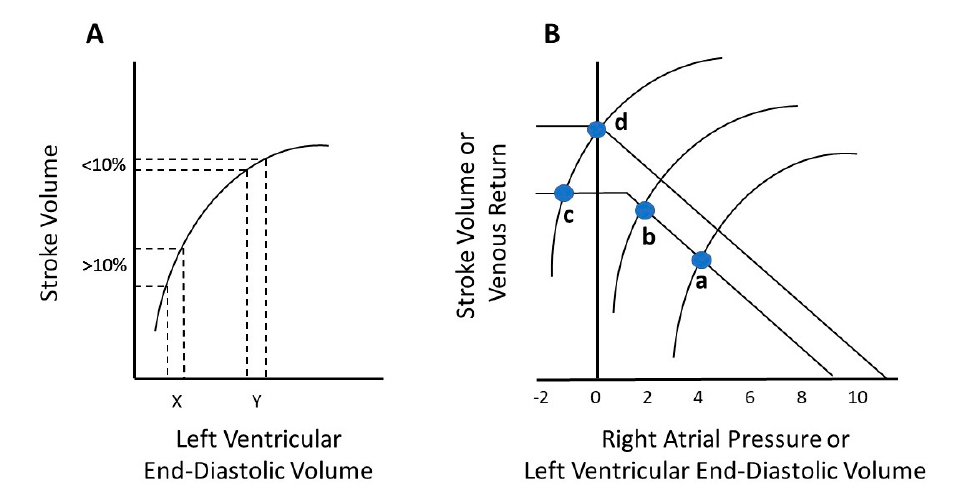
Figure 3. Frank–Starling curve ( A ). An increase in stroke volume of > 10% after a fluid bolus is indicative of fluid responsiveness (X). When stroke volume increases < 10% in response to fluid administration (Y), further fluid resuscitation is not indicated, and the “peak of the Frank–Starling curve” is reached. Guyton’s venous return curve interposed on Frank–Starling curve ( B ). Point (a) is the intersection of the venous return and stroke volume curves referred to as the hemodynamic “operating point” of the system. A leftward shift of the Frank–Starling curve from (a) to (b) with an inotrope results in a higher stroke volume and a lower right atrial pressure (RAP). A decrease in RAP to sub-atmospheric levels causes collapse of the great veins entering the thorax and prevents stroke volume and venous return from increasing (c), despite the further leftward shift of the Frank–Starling curve. The addition of fluids could move the operating point from (c) to (d) by increasing the stressed volume and mean systemic filling pressure, which is the upstream pressure for venous return to the right heart.